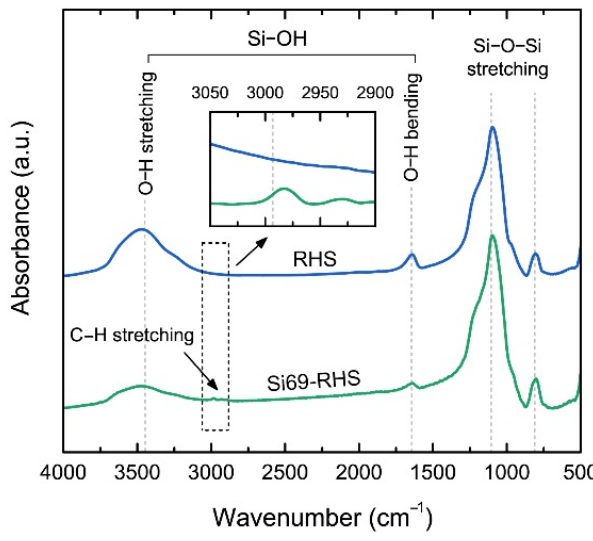
Figure 4. Comparative FTIR spectra of RHS and Si69-RHS.